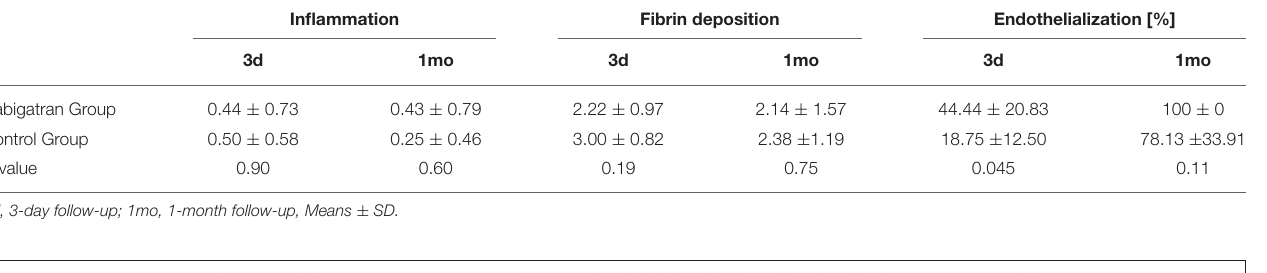
TABLE 2 | Histopathologic results.